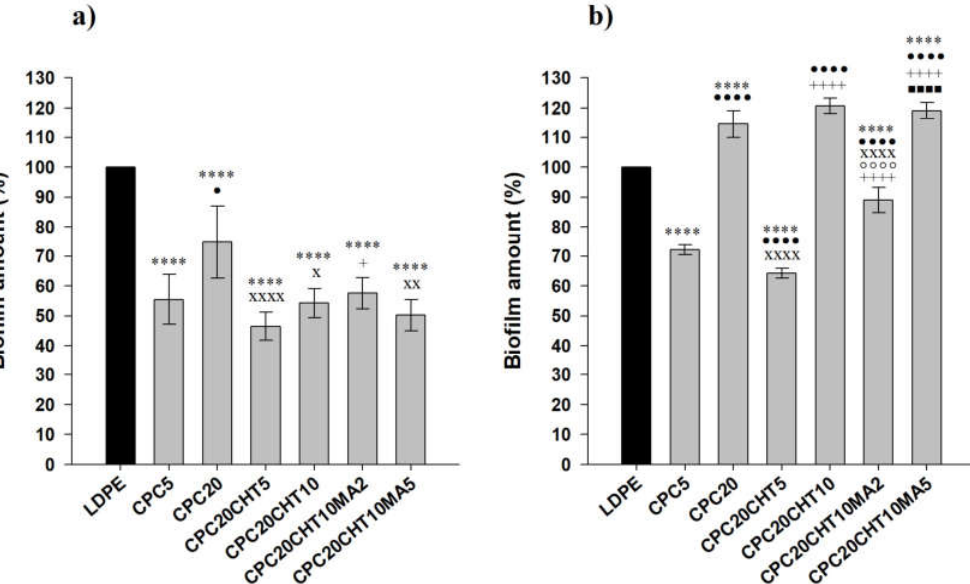
Figure 9. P. putida ( a ) and S. aureus ( b ) biofilm amount on pristine LDPE and biocomposites. The normalized mean values ± SD for three independent experiments with two technical replicates are each illustrated. The significance levels between the groups were 1 symbol— p < 0.05, 2 symbols— p < 0.01, 3 and 4 symbols— p < 0.0001 related to: * LDPE; • CPC5. x CPC20, + CPC20CHT5, ○ CPC20CHT10, ■ CPC20CHT10MA2.